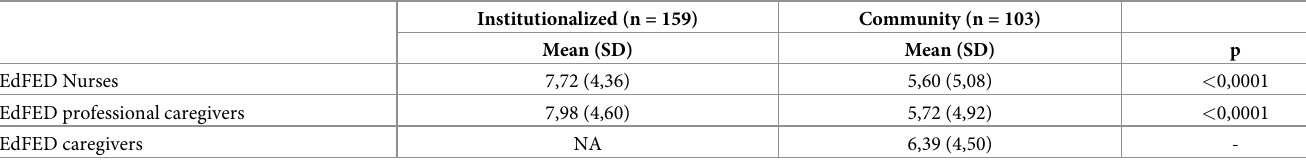
Table 5. Differences in EdFED scores between institutionalized and community subjects.